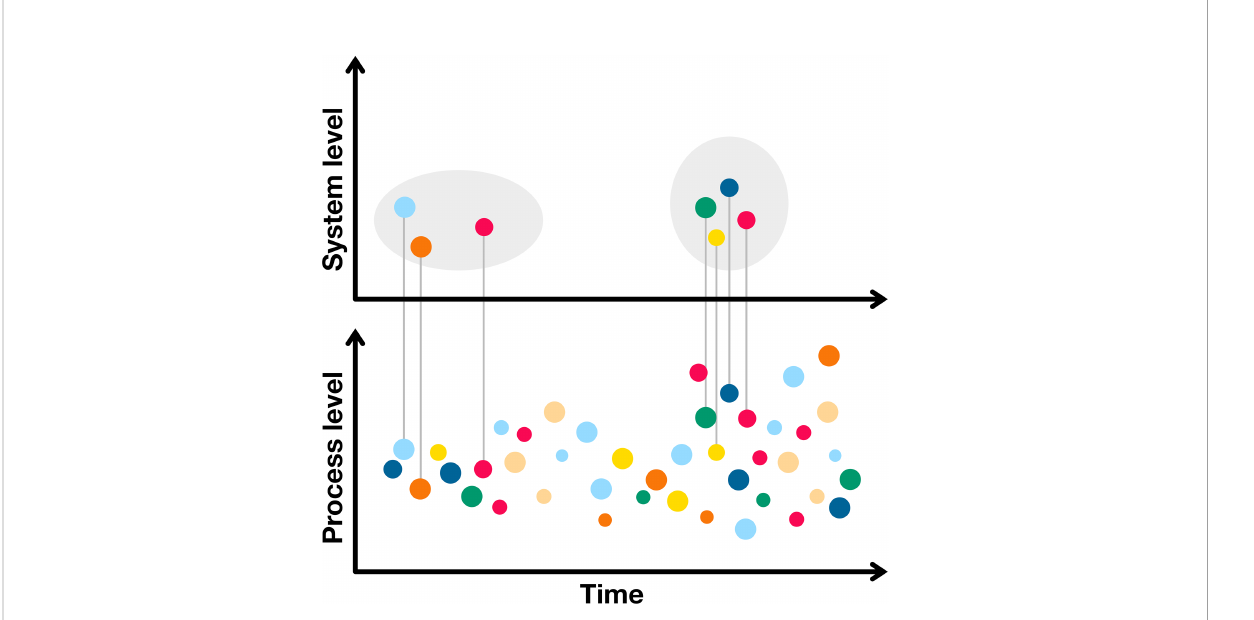
FIGURE 4 Sketch of how processes and systems change over time. The circles indicate various processes, some of which form parts of